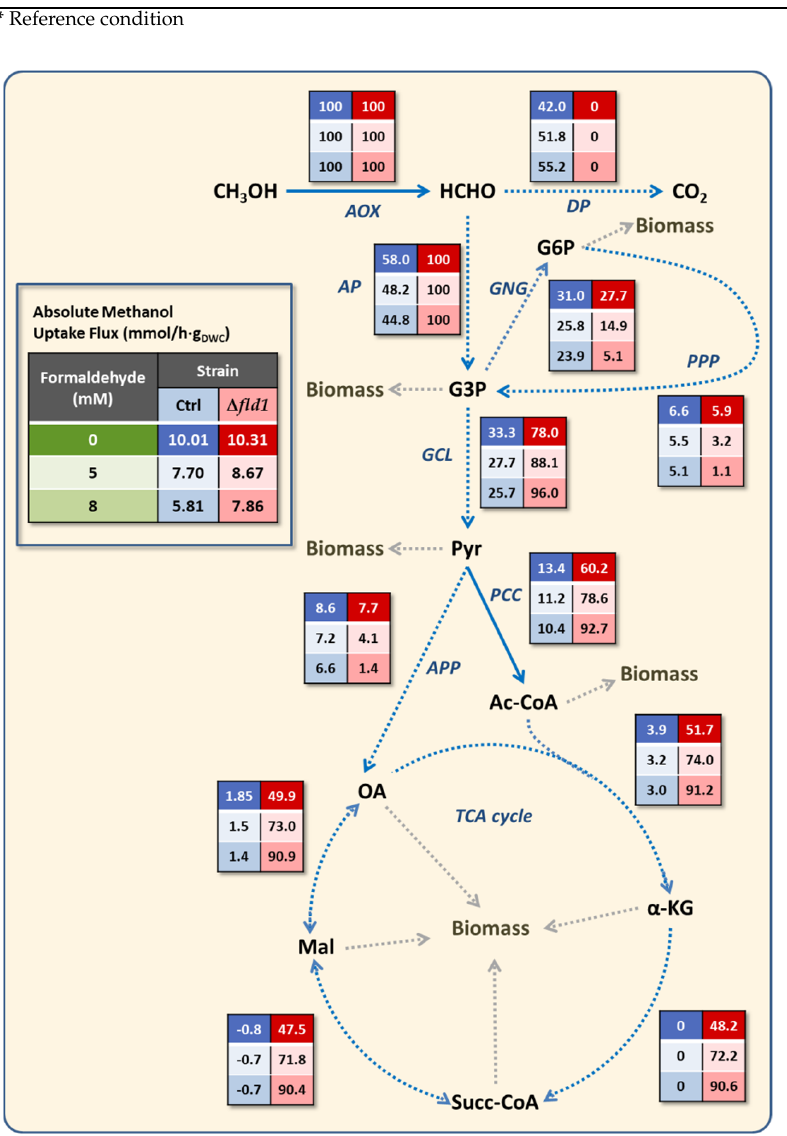
Figure 5. Simplified map of the metabolic flux distribution of methanol uptake in K. phaffii (blue columns: control strain; red columns: Δ fld1 strain). The list of the metabolic reactions is provided in Supplementary File S1. Results are shown as percentage of the methanol uptake flux with no pulse (0) and after 5 or 8 mM formaldehyde pulse (rows). AOX: alcohol oxidase; DP: dissimilative path- way; AP: assimilative pathway; GNG: gluconeogenesis; GLC: glycolysis (from G3P onwards); PDH: